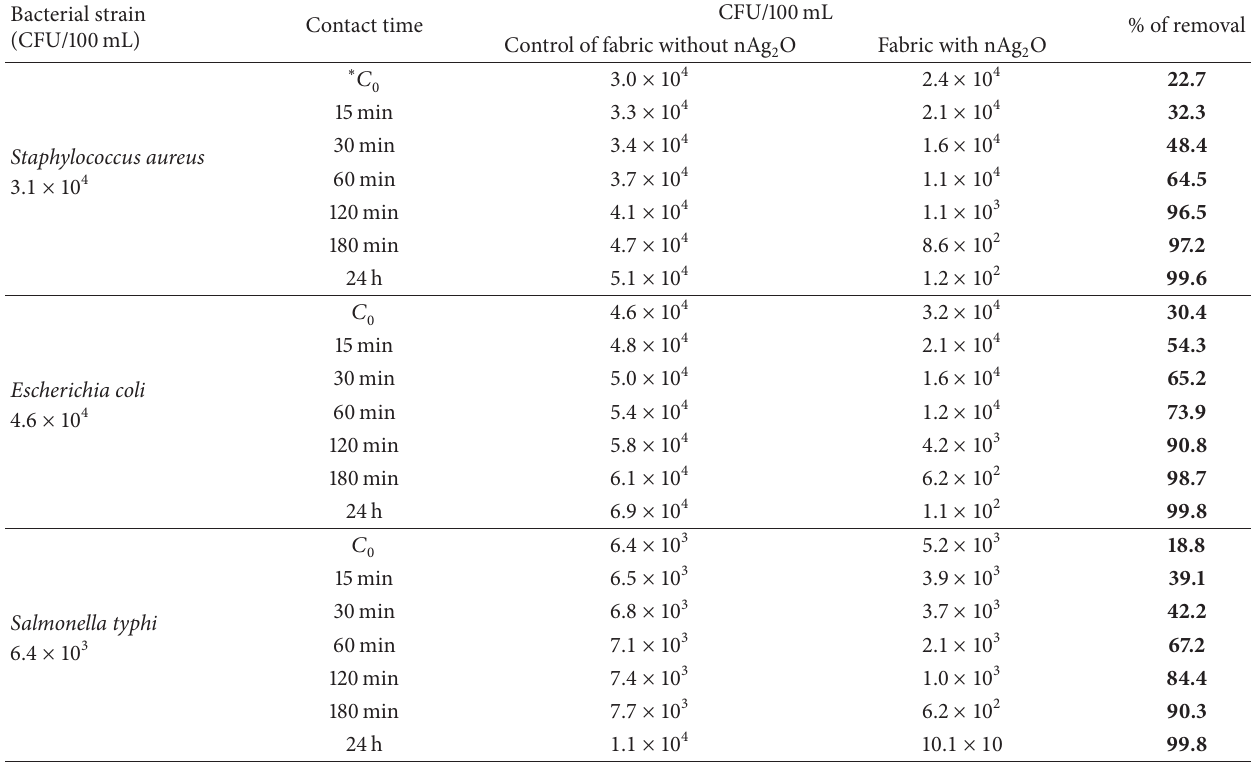
Table 2: Effect of contact time for bacterial reduction using nano-Ag-oxide.